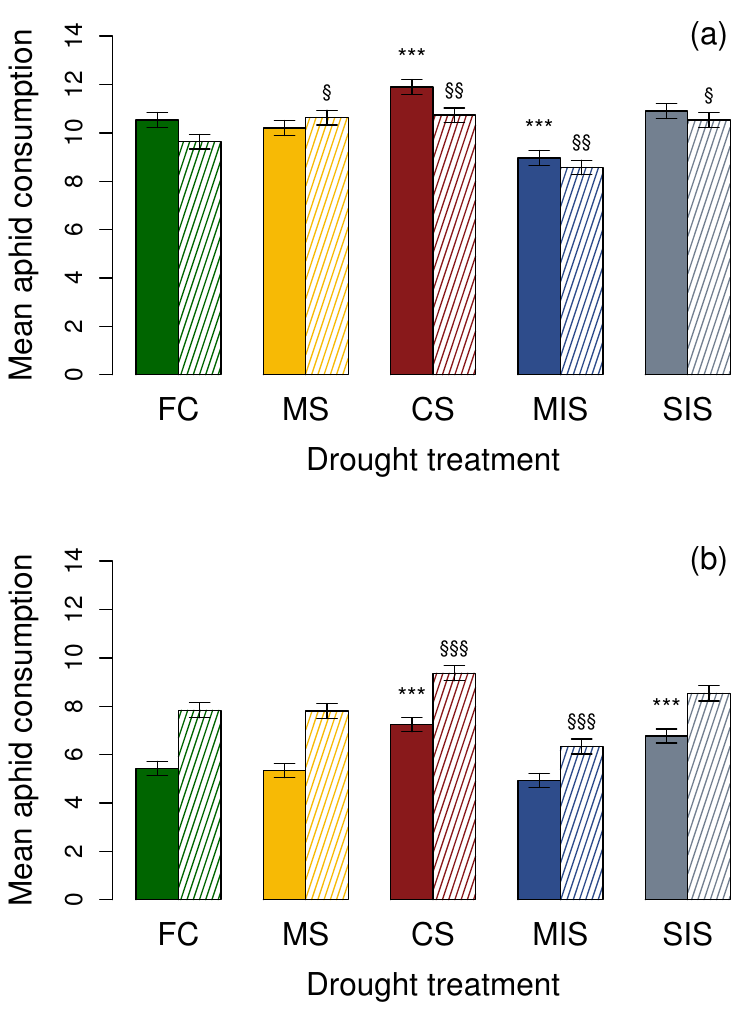
Figure 2. The effect of drought stress on mean number of 3rd instar E. abietinum consumption by ( a ) Aphidecta obliterata and ( b ) Adalia bipunctata 1st instar larvae, as number consumed over 24 h ± LSD. Solid colours = in presence of a Sitka spruce segment; Dashed = no Sitka spruce segment. Error bars and significance indicated against FC with respect to host plant presence or absence. FC = field capacity; MS = 60% field capacity; CS = 20% field capacity; MIS = allowed to fluctuate from 70% to 30% field capacity; SIS = allowed to fluctuate from field capacity to 20% field capacity. *** or §§§ = p < 0.001; ** or §§ = p < 0.01; * or § = p <